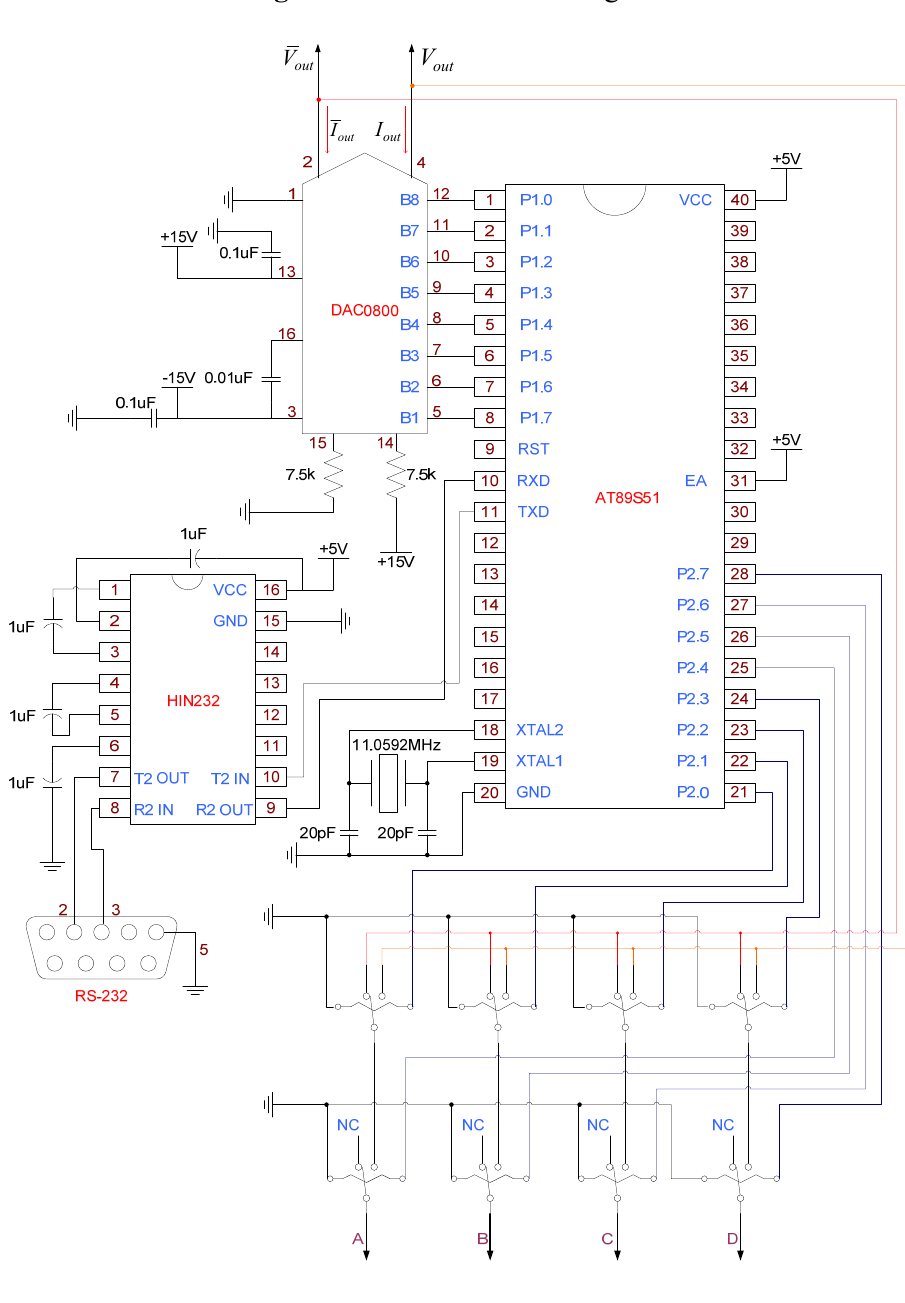
Figure 11. Control circuit diagram.